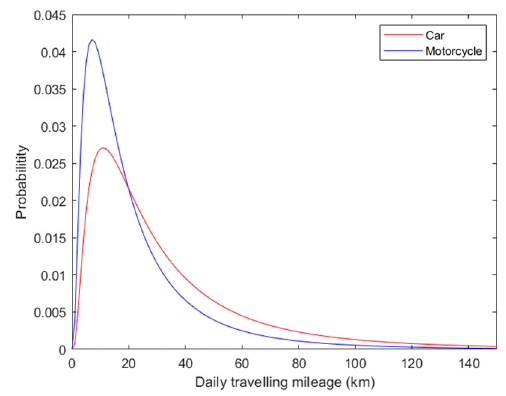
Figure 5. Probability distribution of daily travelling mileage.